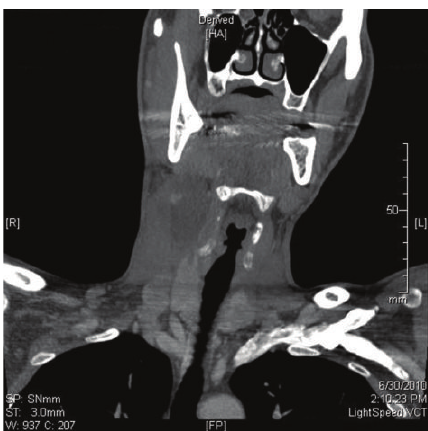
Figure 1: Coronal view of a CT scan with contrast showing right cystic neck mass. Lateral calcification corresponds to the area of malignancy.